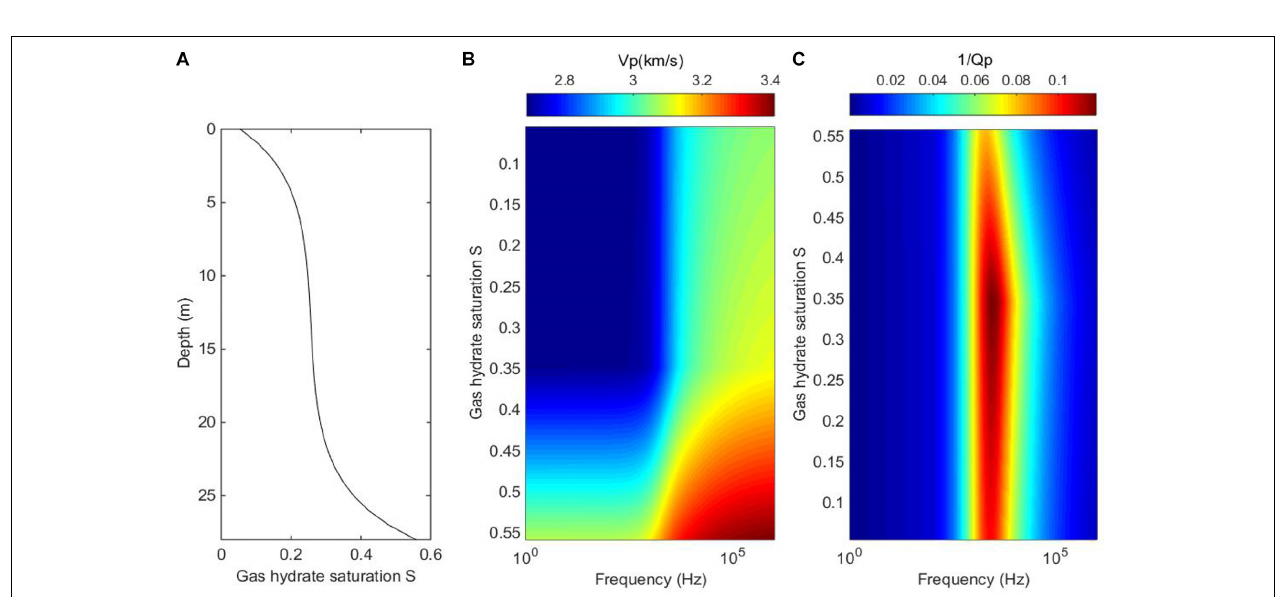
FIGURE 11 | Post-stacked seismograms corresponding to Figures 9 , 10 . (A) PP reflections (B) mode-converted PS reflections.